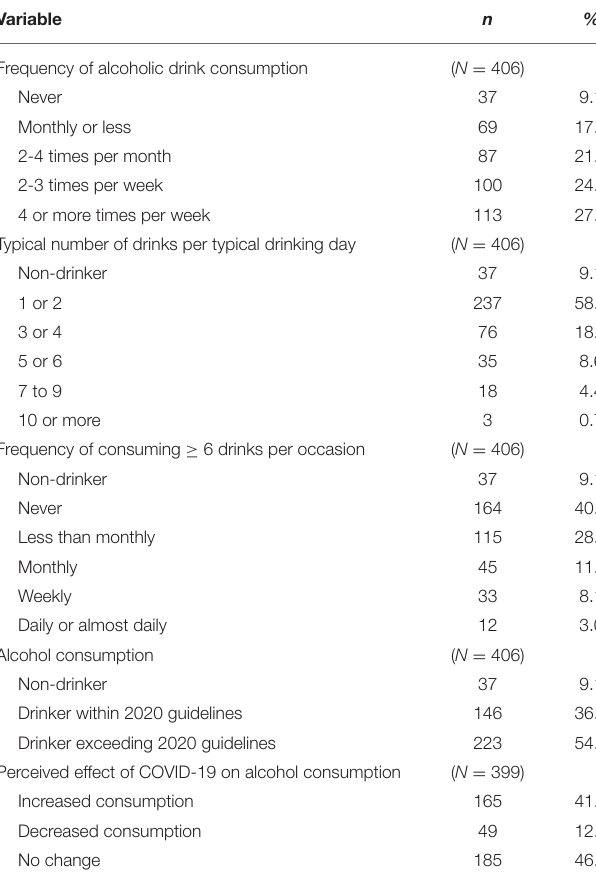
TABLE 3 | Alcohol-related characteristics of eligible survey